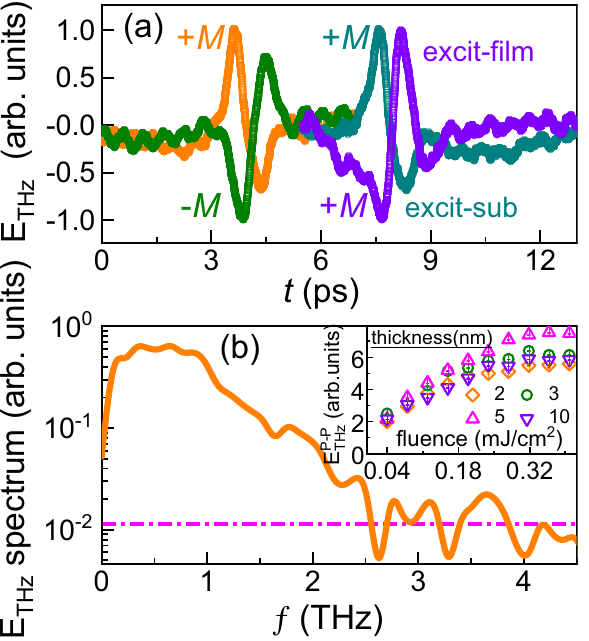
Figure 3. ( a ) Peaks at ∼ 4 ps: THz waveform in time-domain ( t ) for substrate/CoFeB (5 nm)/cap emitter with different magnetization directions ( ± M ) when pumping from substrate side. Peaks at ∼ 8 ps: THz waveform pumping from the capping layer and substrate sides while keeping the same magnetization direction. Time scale is shifted for better visualization of both cases. ( b ) Fast Fourier transform of THz electric field and the inset shows THz peak-to-peak amplitude for substrate/CoFeB( t CoFeB nm)/cap emitters as a function of pump fluence.